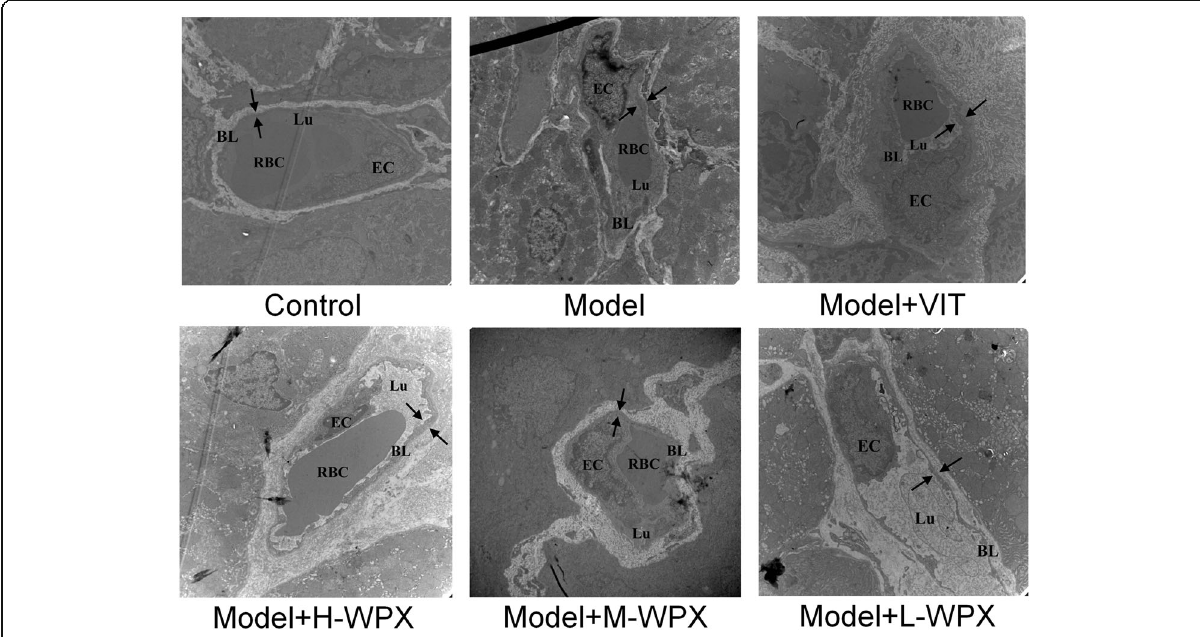
Fig. 5 Representative electron micrographs of microvessels in gastric mucosa. Control group : TEM observation of control microvessel ultrastructures appeared intact, in terms of vascular lumen, basal lamina and endothelial cell. Model group : Microvessels lost their typical structures. Vascular lumen, frequently plugged by erythrocytes, was dilated but with a markedly decreased inner diameter. Clearly thickened, rough basal lamina was coated by abundant high-density granules aggregation. Segmental breakup of basal lumina and increased vascular permeability were also existed. Endothelial cells were conglobated and shaped as grapes, characterized by debased cytoplasm electron-density, nucleus chromatin condensation, as well as numerous pinocytotic vesicles. Treatment group : Microvascular abnormalities were still prominent in VIT-treated tissues. However, the abnormalities reversed markedly in WPX-treated tissues, especially in terms of vascular lumen and basal lamina. Even in a few cases, the microvessels were detected to ultrastructurally resemble the normal ones. Note: Opposing arrows mark the thickness of basal lamina; EC, endothelial cell; BL, basal lamina; Lu, lumen; RBC, red blood cell. n =9 in each group.